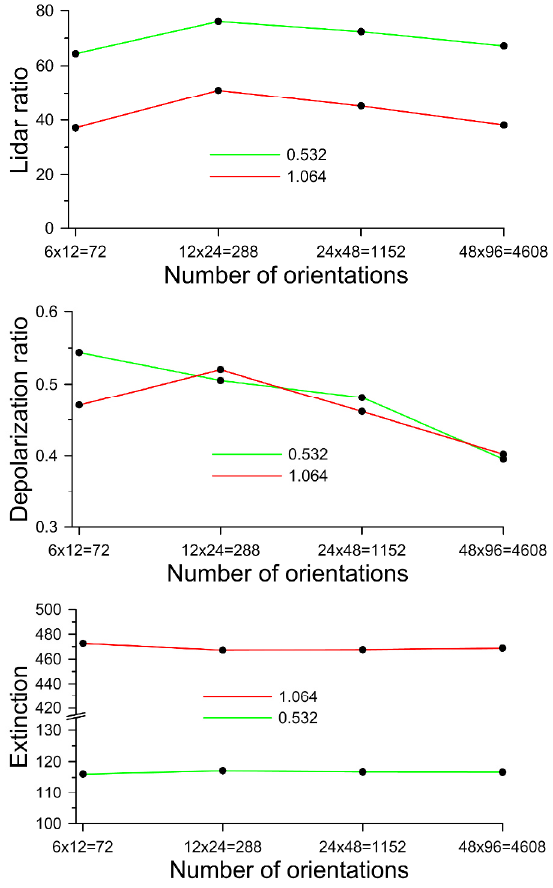
Figure 3. The lidar and depolarization ratio, and extinction coefficient vs. number orientations.